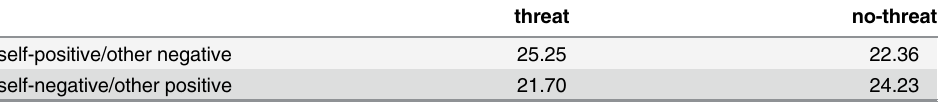
Table 2. Means of Trait self-esteem sum scores of the four participant groups.